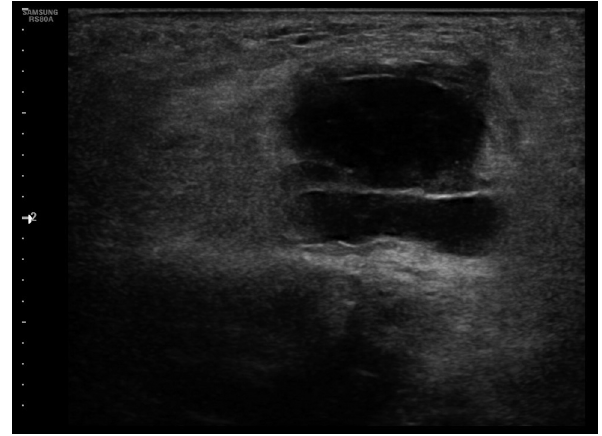
Fig. 2 Ultrasound scan of hypoechoic bilobulated mass with het- erogeneous content and perilesional edema.